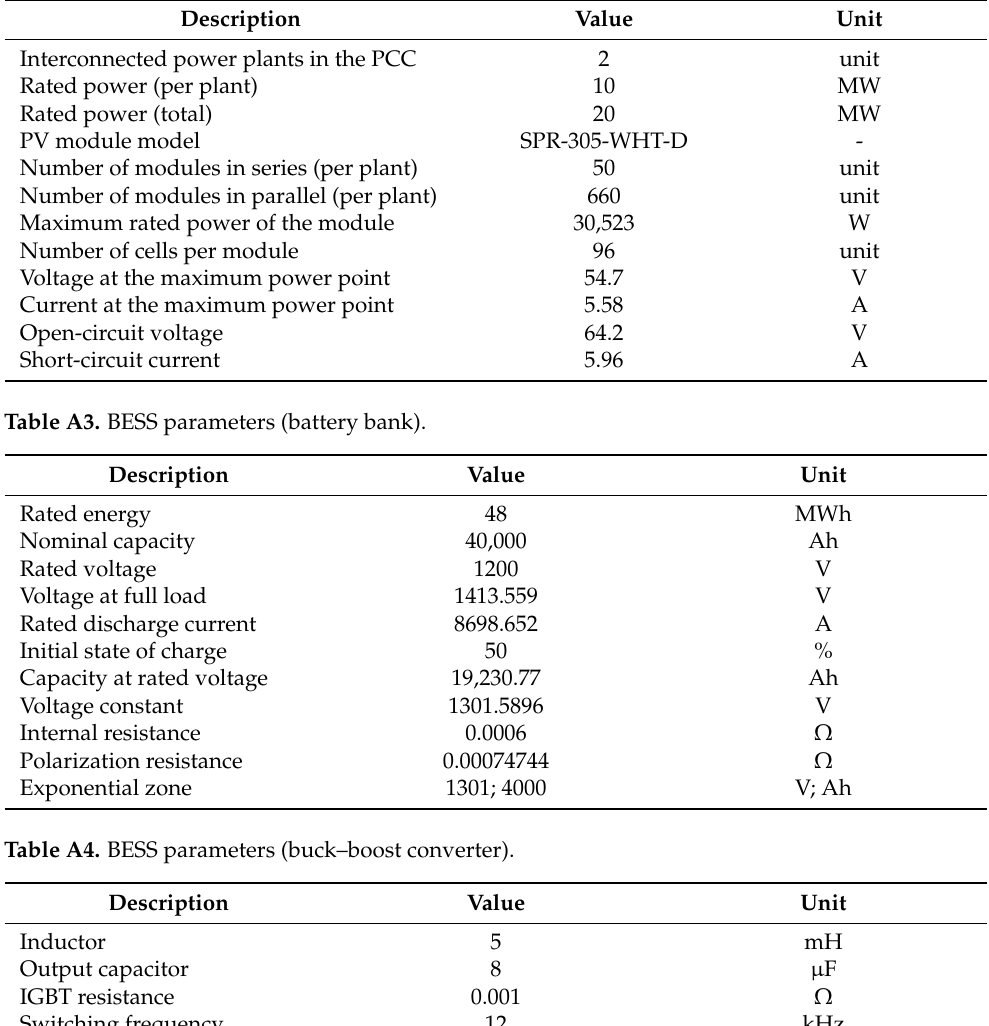
Table A2. Solar power plant parameters.